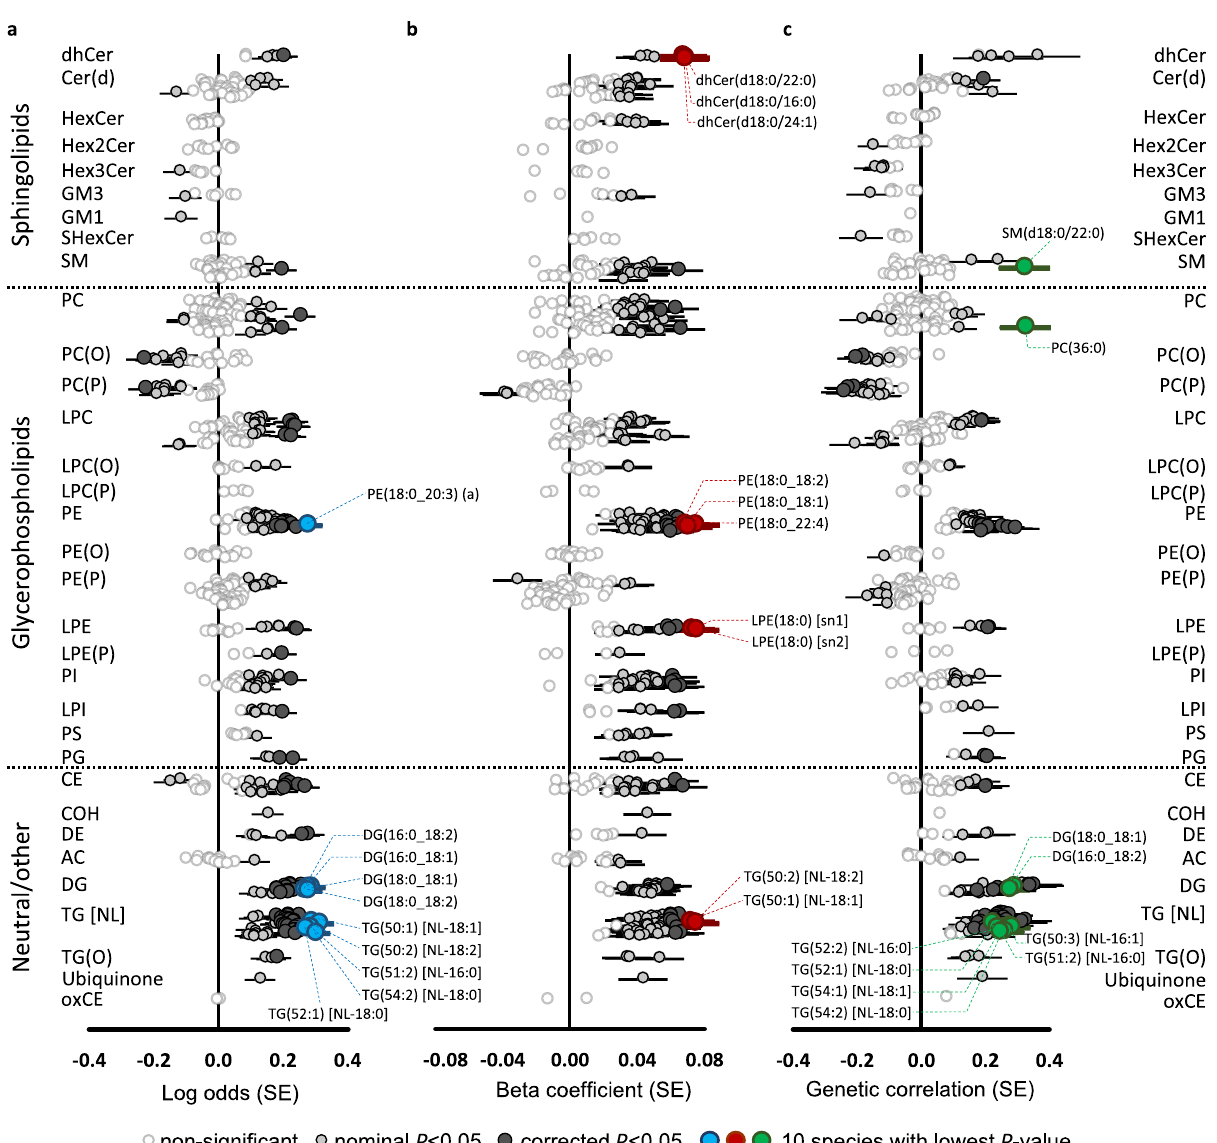
Data 15). The strongest genetic correlations were between TG(51:2) [NL-16:0] (0.275 ± 0.058, P = 2.22 × 10 − 6 , FDR q = 8.94 × 10 − 4 ) and CAD.